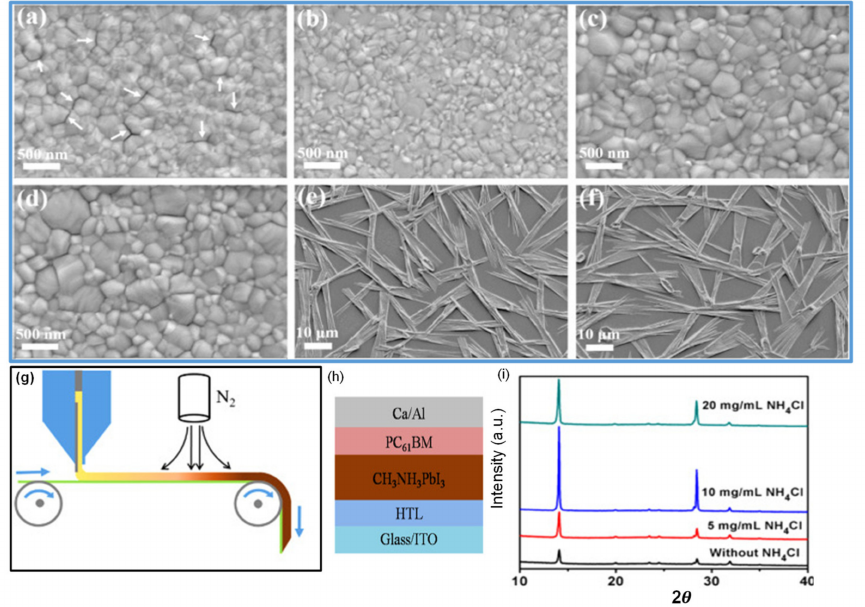
Figure 8. ( a – f ) SEM images for CH 3 NH 3 PbI 3 films prepared using di ff erent conditions: ( a )